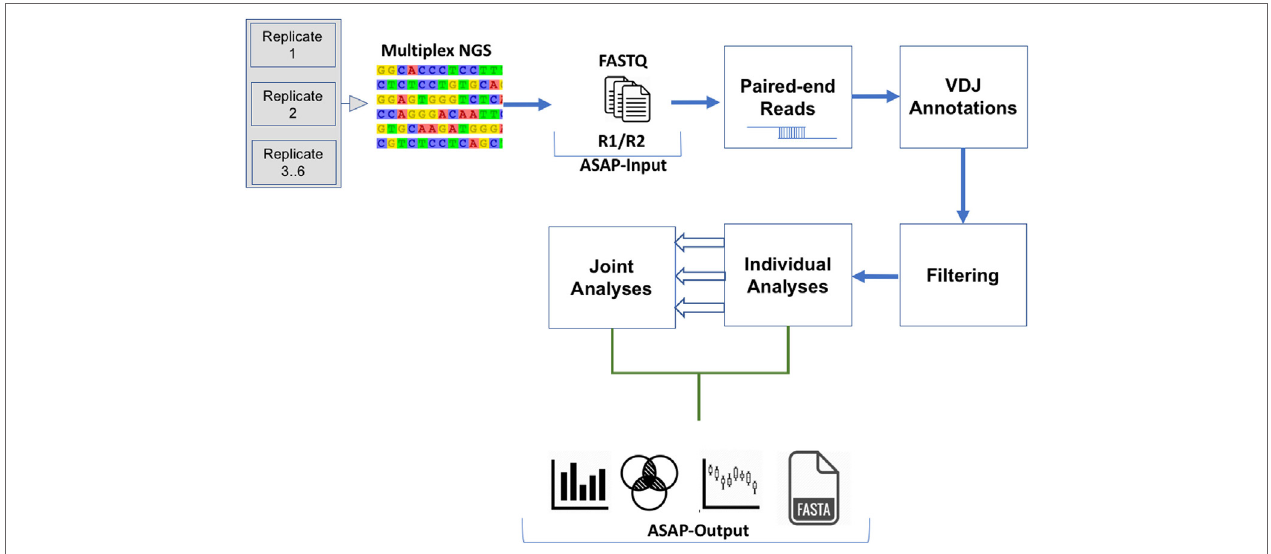
FIguRe 2 | Schematic flowchart for the analysis of each next-generation sequencing replicate (individual) as well as the analyses of the entire set of replicates